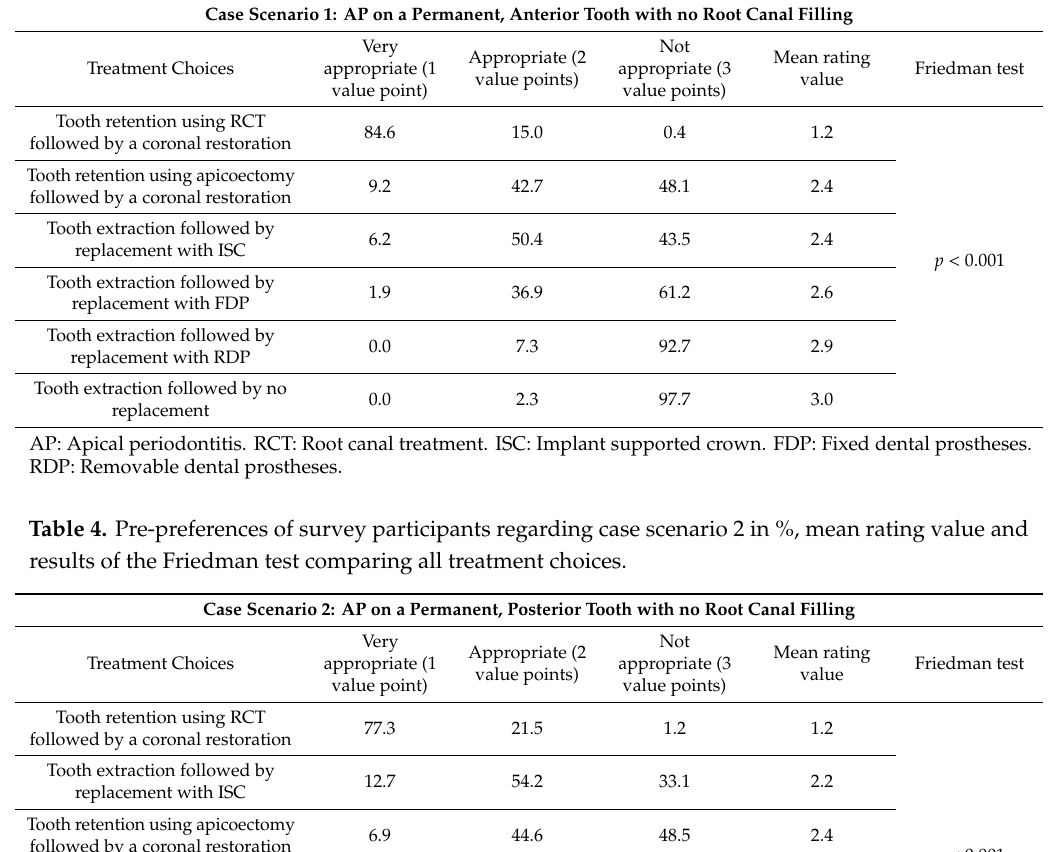
Table 3. Preferences of survey participants regarding case scenario 1 in %, mean rating value and results of the Friedman test comparing all treatment choices.